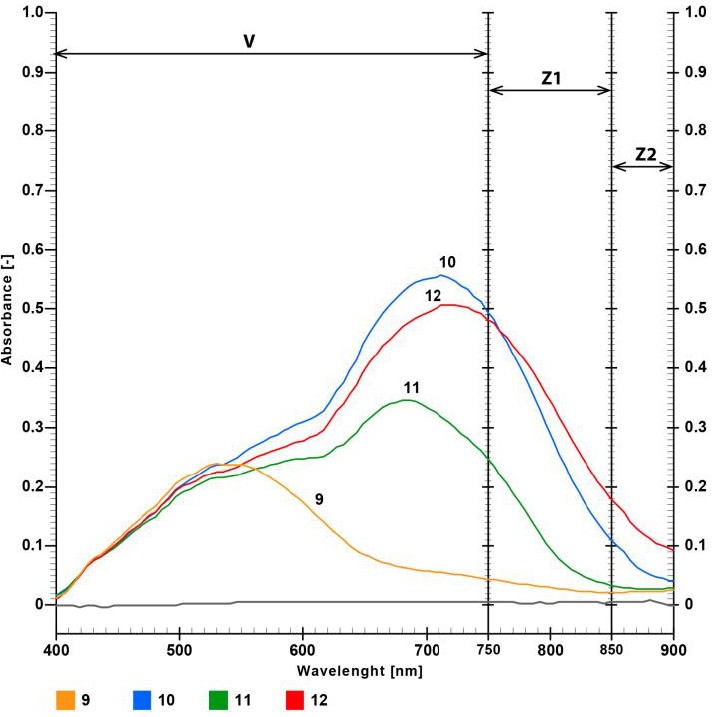
Figure 6. Dyes 9, 10, 11, and 12 (third row in Figure 1).